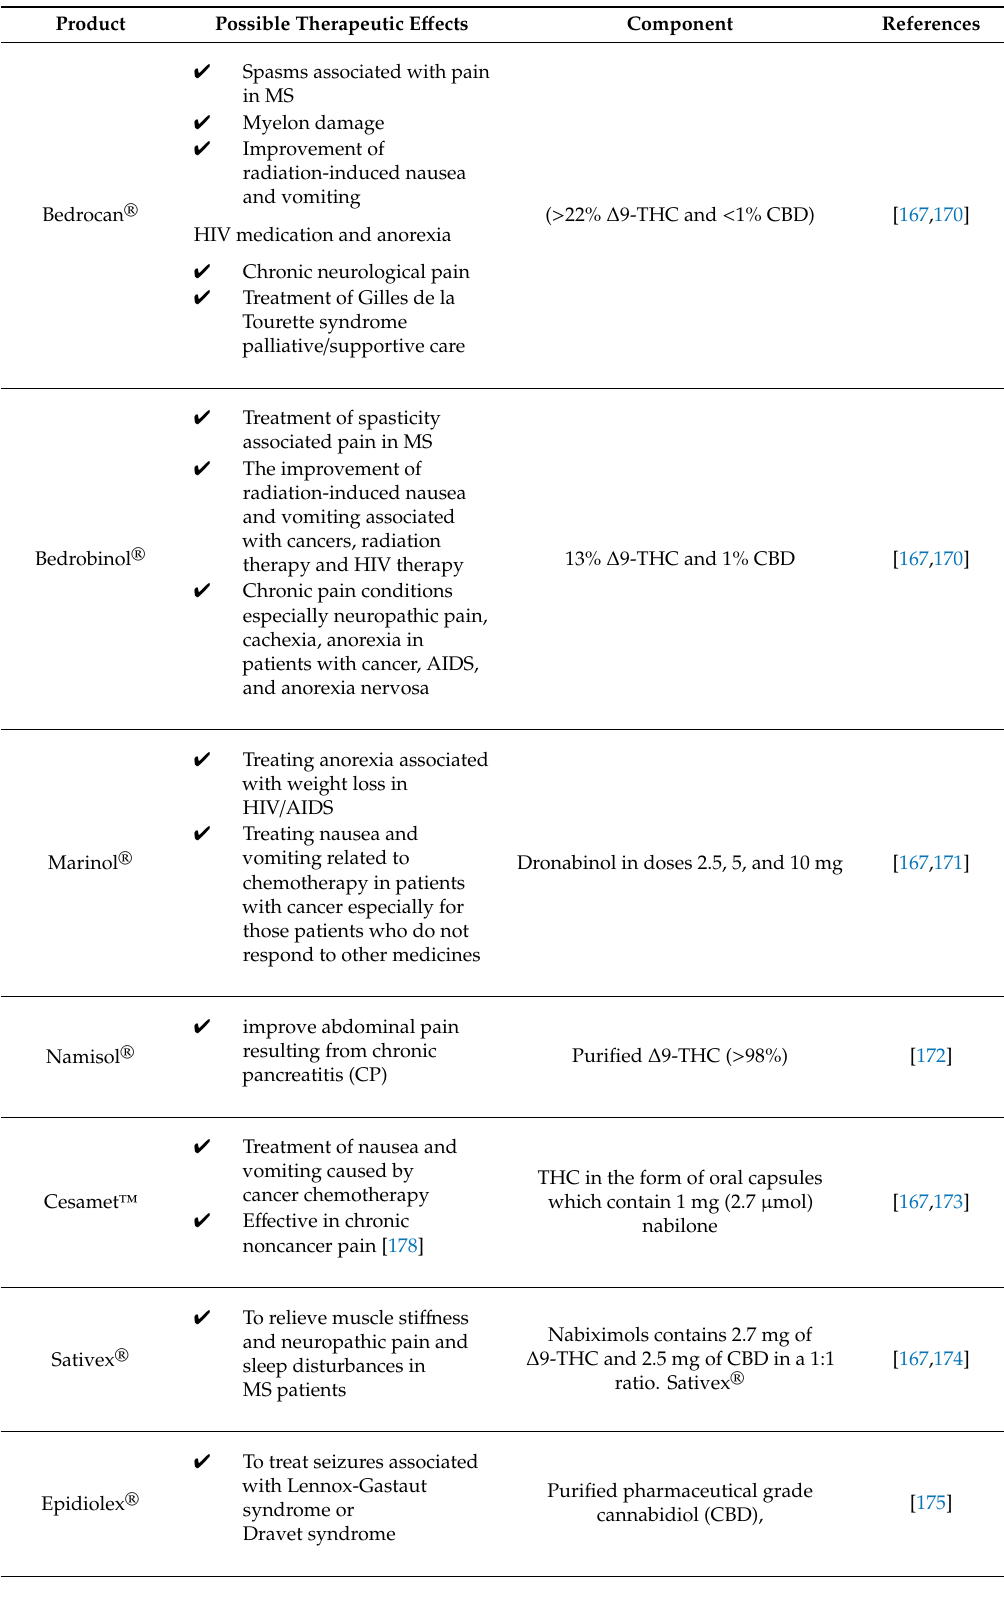
Table 2. Summaries of di ff erent forms of cannabinoids available on the world market or under development and clinical